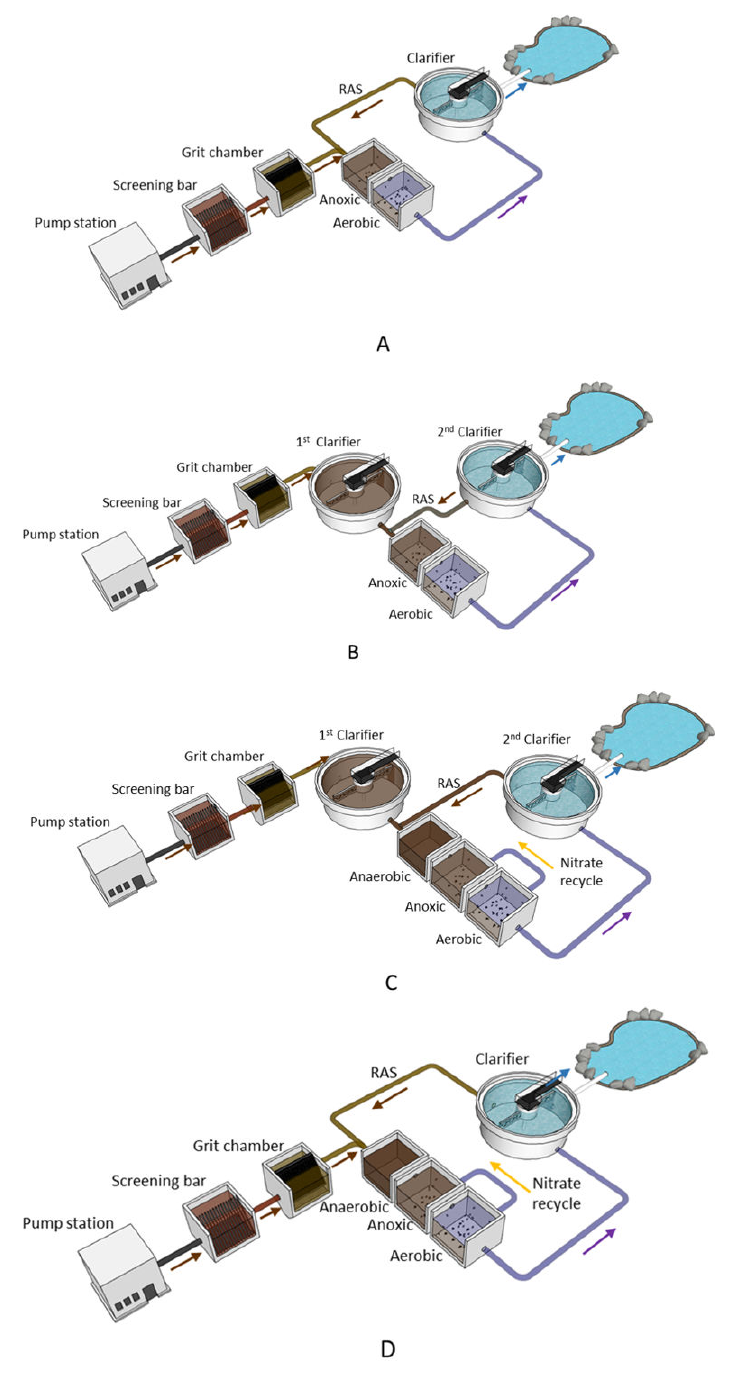
Figure 1. The schematic layout of the full-scale WRRFs at ( A ) L1, ( B ) H1, ( C ) L2, and ( D )